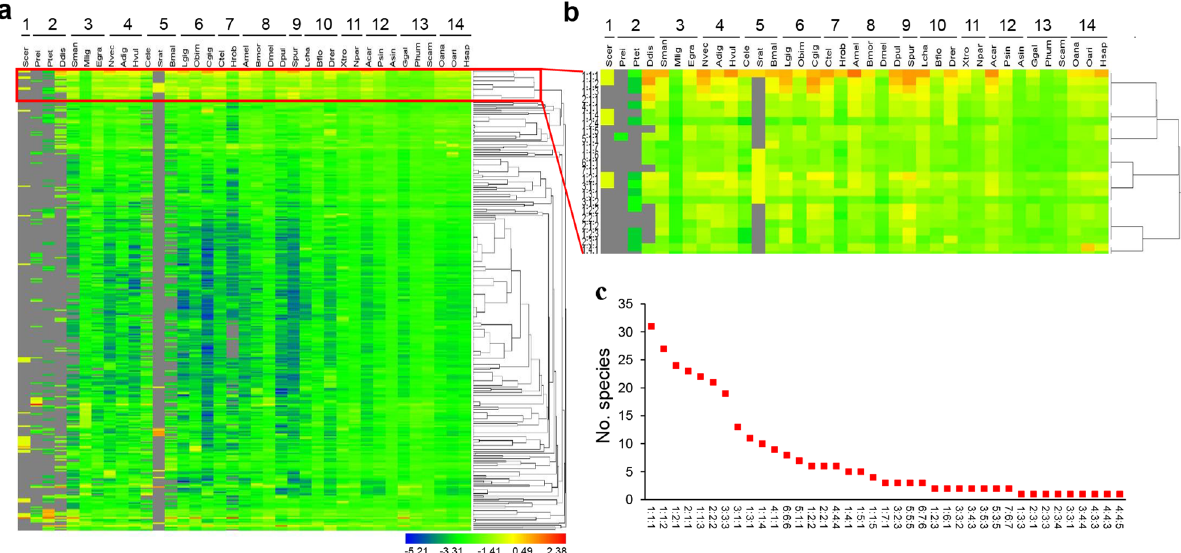
Fig. 5 Loop lengths of the (G/C) 3 L 1 – 7 G4 motifs in the genomes of the 37 representative species. a Heat map presentation and hierarchical clustering of the proportion of the (G/C) 3 L 1 – 7 motifs with each of the loop-length types. b Zoomed out view of one cluster in a , showing the G4 motifs with a relatively higher proportion in the majority of the species. c Species communality of the top ten dominant loop-length types of the (G/C) 3 L 1 – 7 motifs in each species. The Y -axis shows the number of species that have the corresponding loop-length type of the (G/C) 3 L 1 – 7 motifs in their top ten motifs. Numbers spaced by colons indicate the base length of the fi rst, second, and third loops, respectively. The abbreviation of species is listed in the legend of Fig.